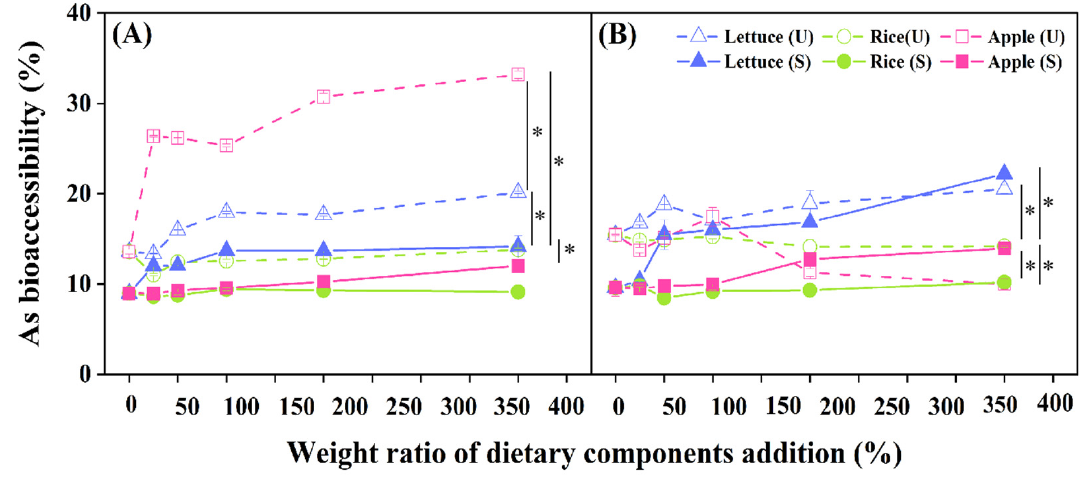
Figure 1. Bioaccessibility of As in the gastric ( A ) and intestinal ( B ) phase after addition of different dietary components before (U) and after (S) FeSO 4 stabilization. Data are presented as the mean ± standard deviation (S.D.) of the three experimental groups. ANOVA analysis reveals the statistical differences between the stabilization treatments and dietary addition groups. An asterisk (*) indicates significant difference between the different dietary addition groups ( p < 0.05). Summary of statistical information including p values is given in Table